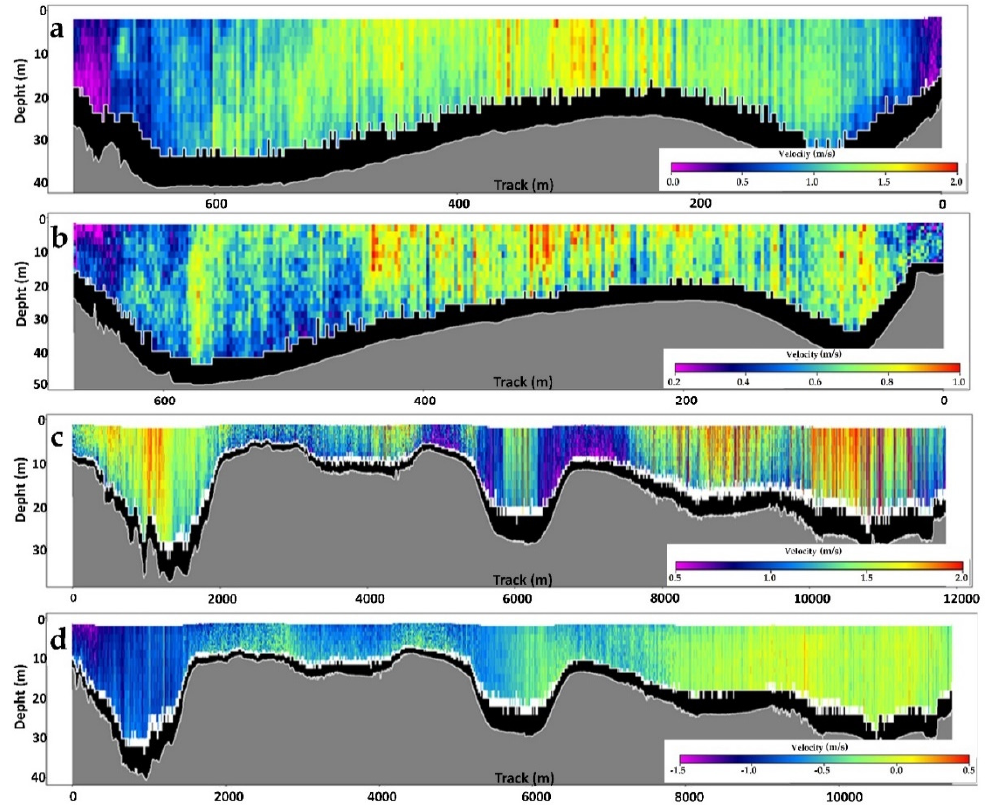
Figure 5. ( a ) Field data of CSA’s velocity. Flow: Q = 22,729 m 3 /s.( b ) Field data of CSA’s velocity. Flood: Q = − 13,381m 3 /s.( c ) Field data of CNM’s velocity (Macapá stretch). Flow rate: Q = 254,943 m 3 /s (ebb). ( d ) Field data of CNM’s velocity (Macapá stretch). Flood rate: Q = − 149,652 m 3 /s (flood).